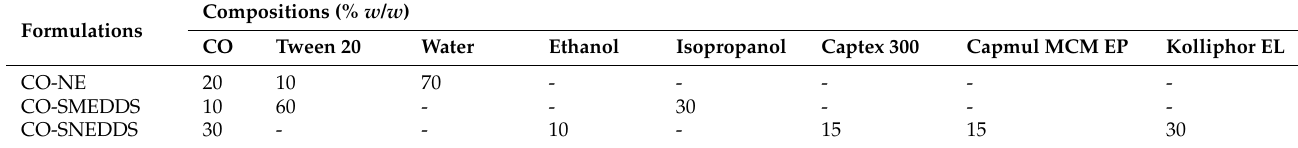
Table 1. Composition of CO